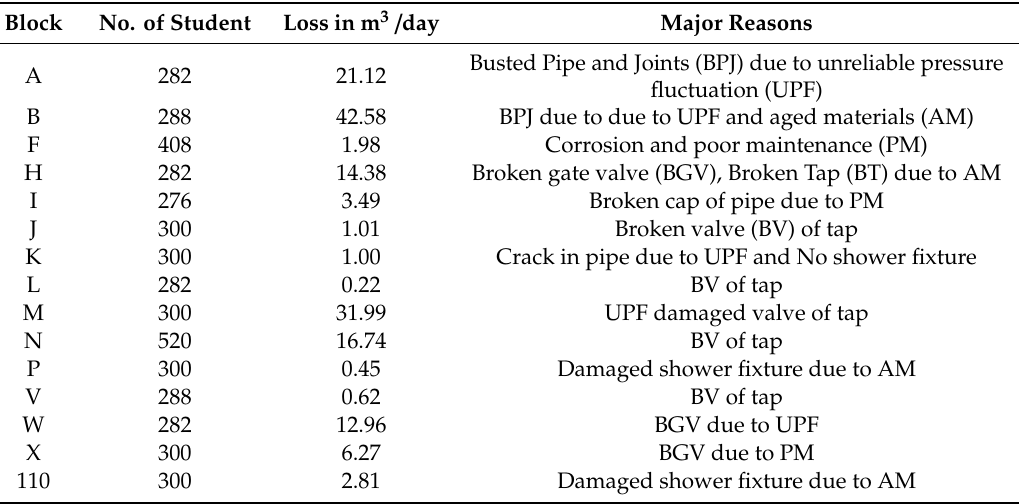
Table 2. Block-wise water loss and their major reasons.